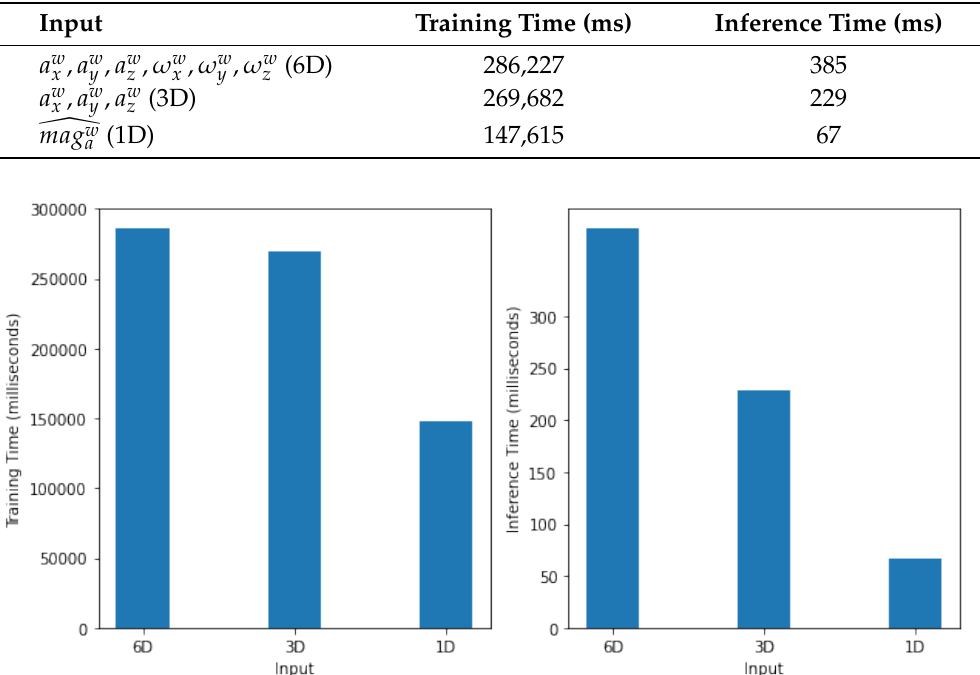
Table 5. Computation time required by the proposed model for the training and inference under different sizes of input signals.